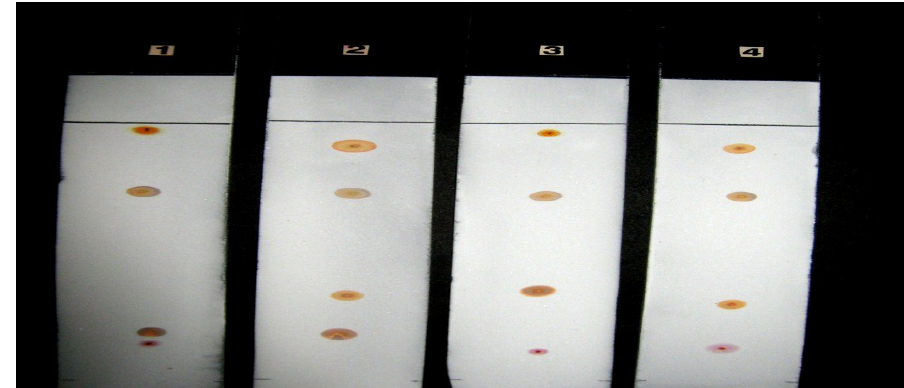
Picture No 3. Quaternary